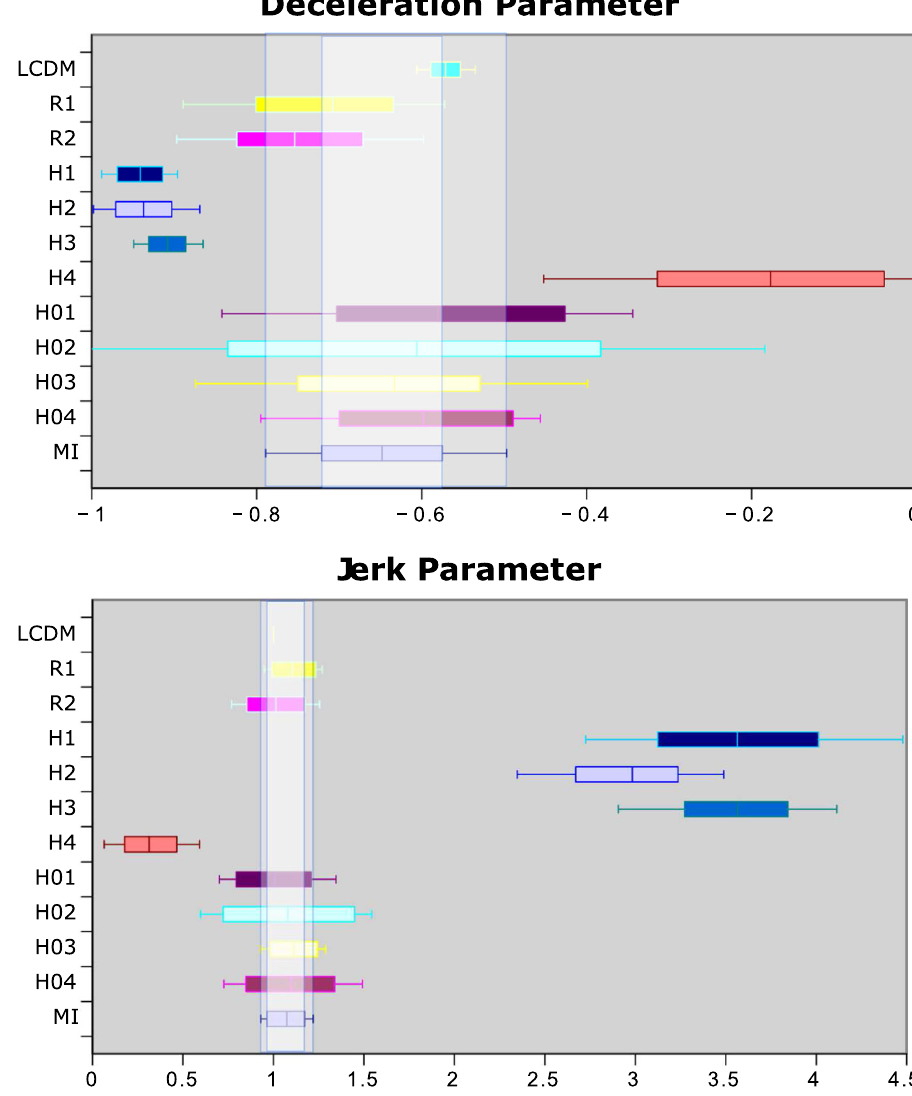
Fig. 1 The computed values of q 0 for the different DE models, using the best fit value of the model parameters and Eq. (41) in the appendix for z = 0, as compared to the model-independent (MI) approach